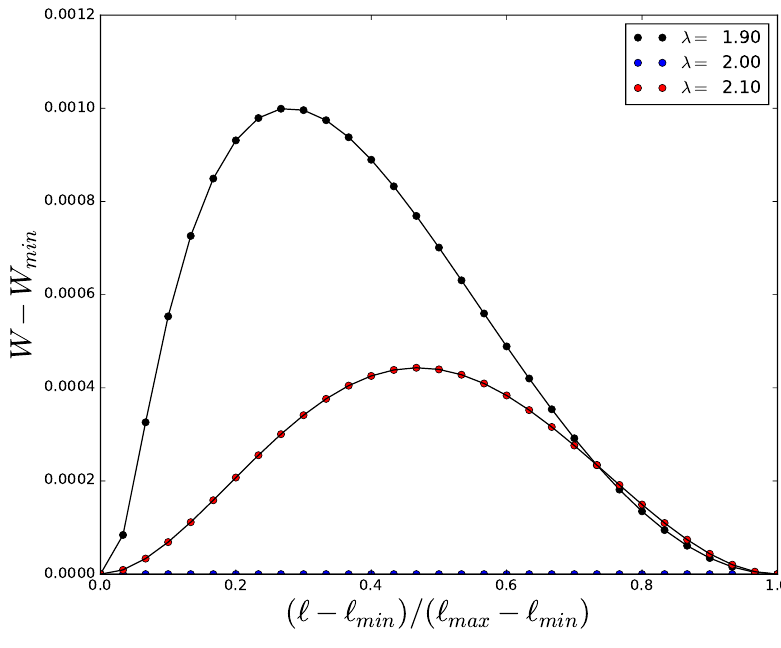
Figure 13: Energy barrier of Peierls-Nabarro to transfer a strong bond (with its elec- trons) onto the next bond, for λ = 1.9,2,2.1. The barrier vanishes at the integrable point λ = 2 and the commensurate CDW is unpinned. Here, p = 0.02, ξ = 1, ξ